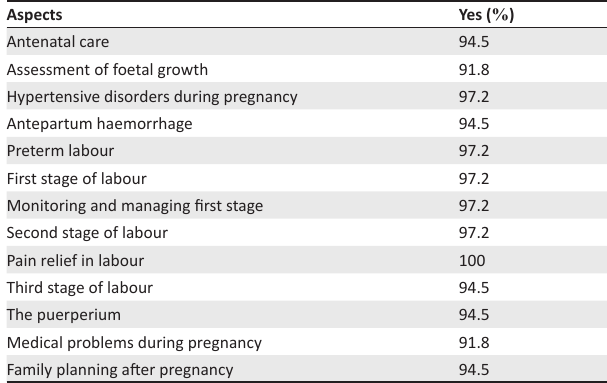
TABLE 2: Adequate coverage and facilitation of theoretical aspects.